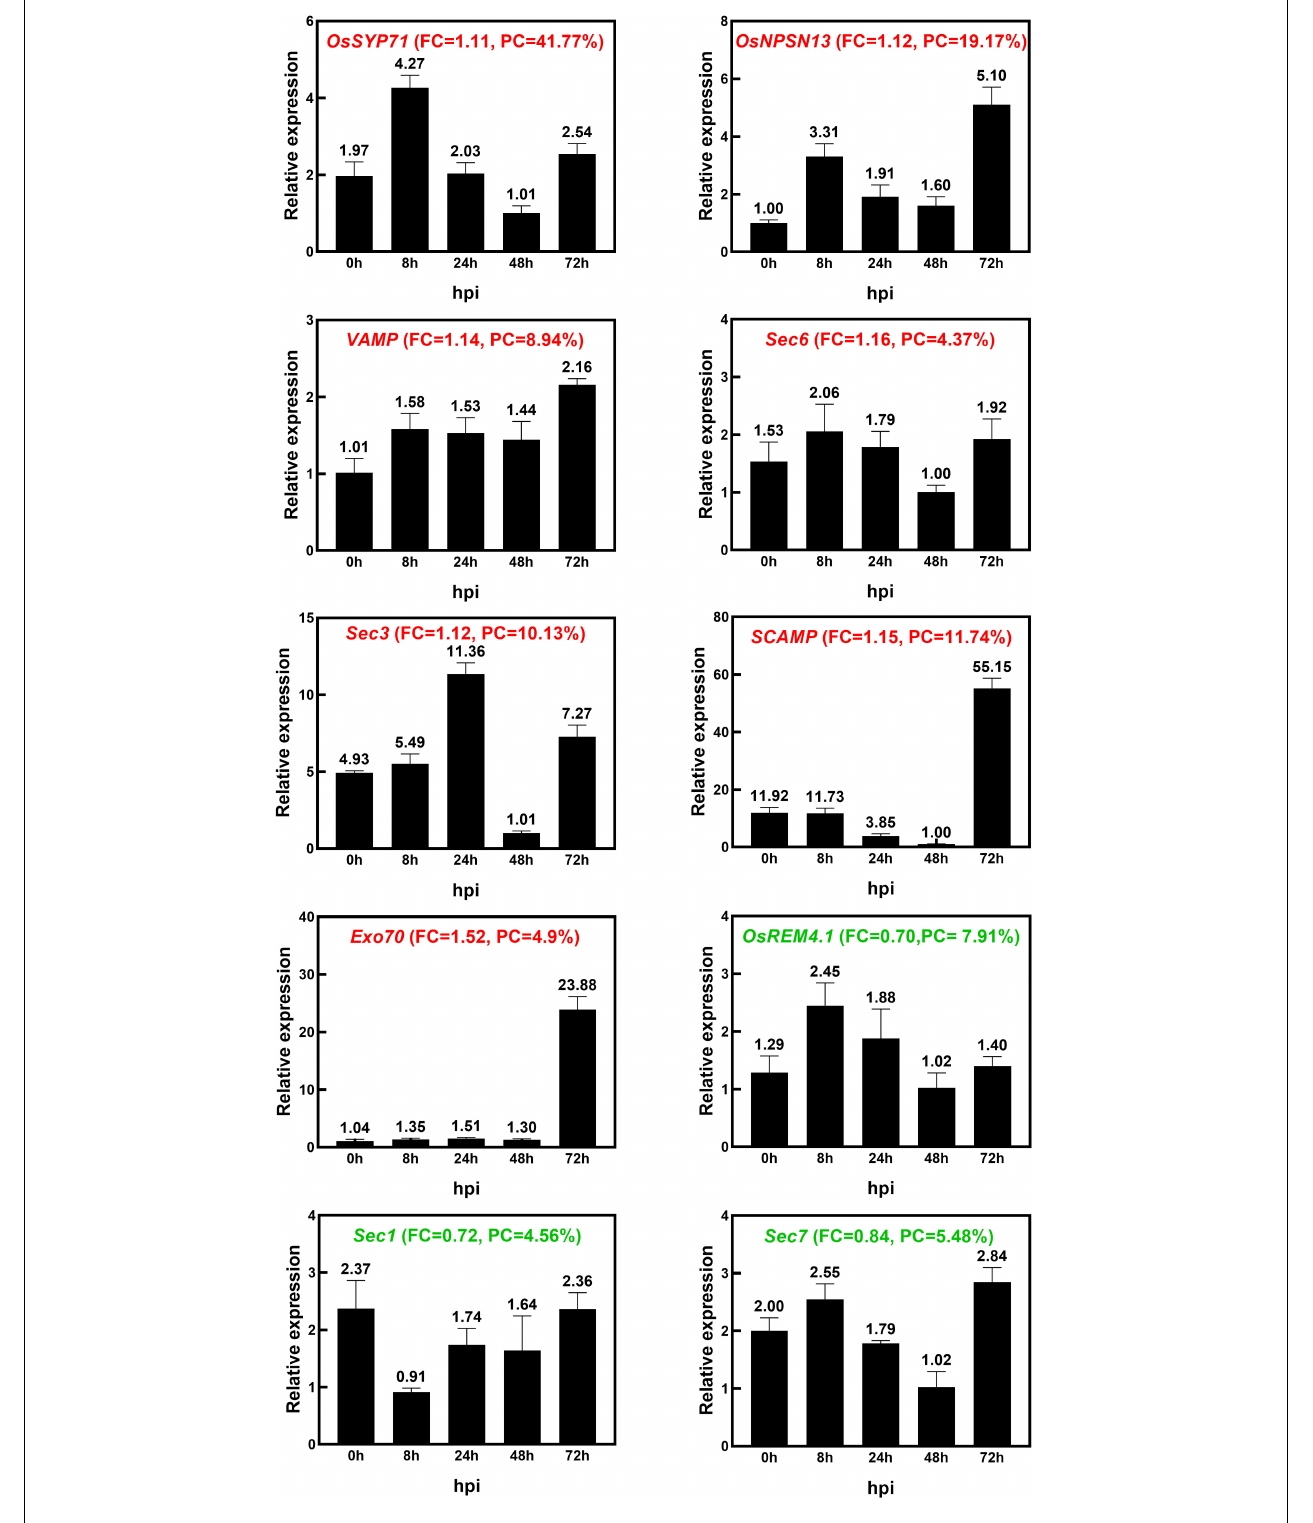
FIGURE 6 | The identification of transcriptional expression patterns of 10 DEPs after M. oryzae infection. The expression patterns of 10 selected DEPs in Heikezijing (Hei) inoculated with the M. oryzae strain Hoku1 were investigated via qRT–PCR. Hei seedlings were collected 0, 8, 24, 48, and 72 h after inoculation. The rice actin gene was used as an internal control. The bar chart shows the average ± standard deviation ( n = 3). The information of Fold Change (FC) and Peptide Coverage (PC) in proteomic data was also shown in the figure. Red and green colored names represent upregulated and downregulated, respectively, in the proteomic analysis.